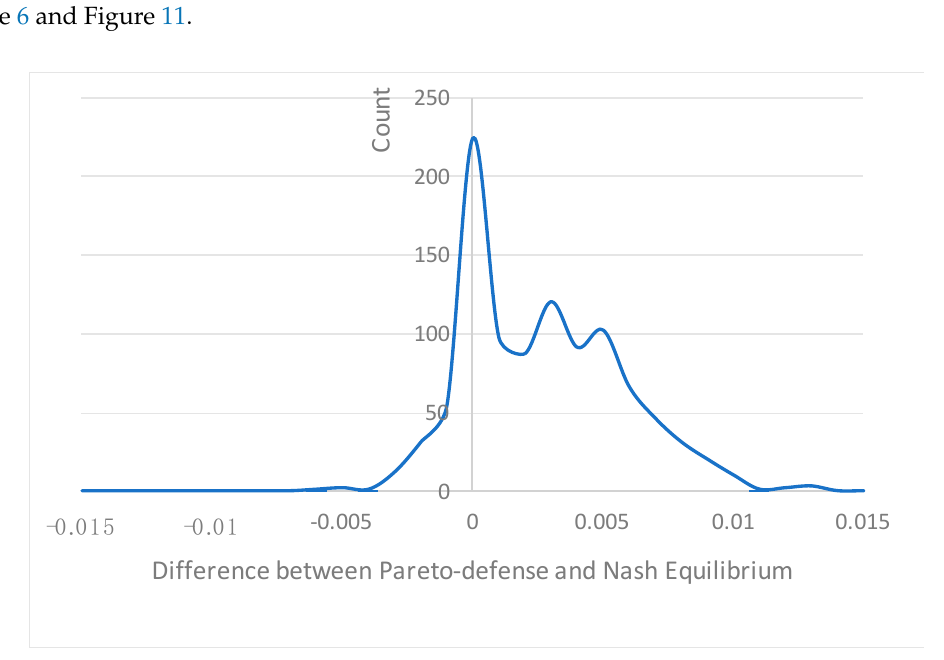
Figure 11. Histogram for difference between Pareto-defense and Nash Equilibrium strategies.